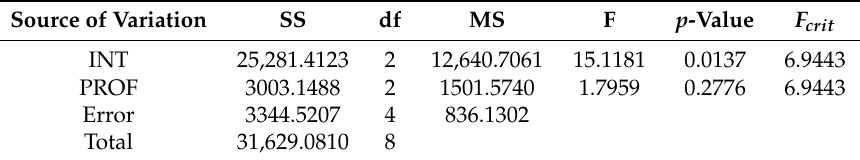
Table 8. Analysis of variance (ANOVA) table for the ethanol productivity, using the DE as the optimization algorithm. The terms SS, df, MS represent the summation of the squared variations, number of degrees of freedom and mean squared variation,